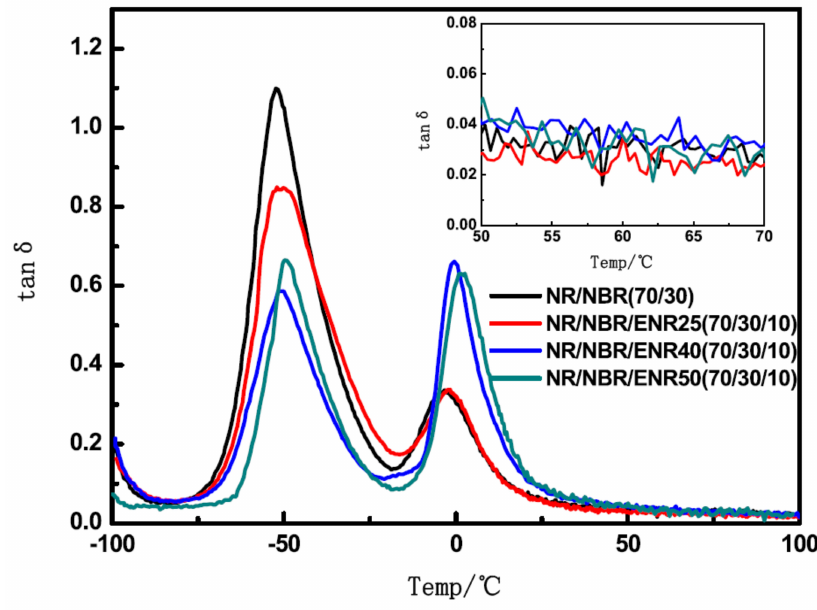
Figure 12. Temperature dependence of the damping loss factor (tan δ ) of NR/NBR (70/30) and NR/NBR/ENR (70/30/10) composites with different epoxidation degrees of ENR